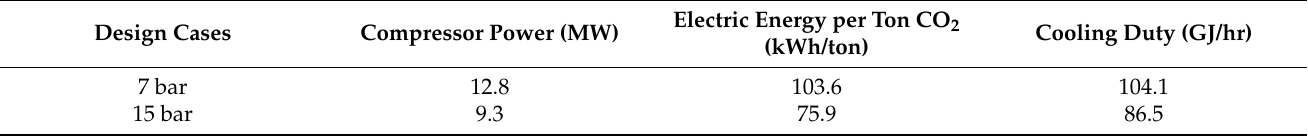
Table 3. Results of the open-cycle liquefaction design with the high-end pressure of 80 bar.